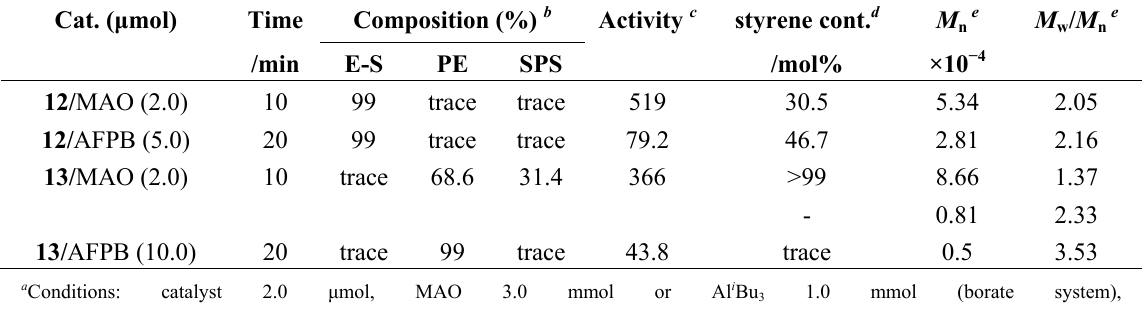
( O -2,6- i Pr C H ) ( 12 2 2 6 3